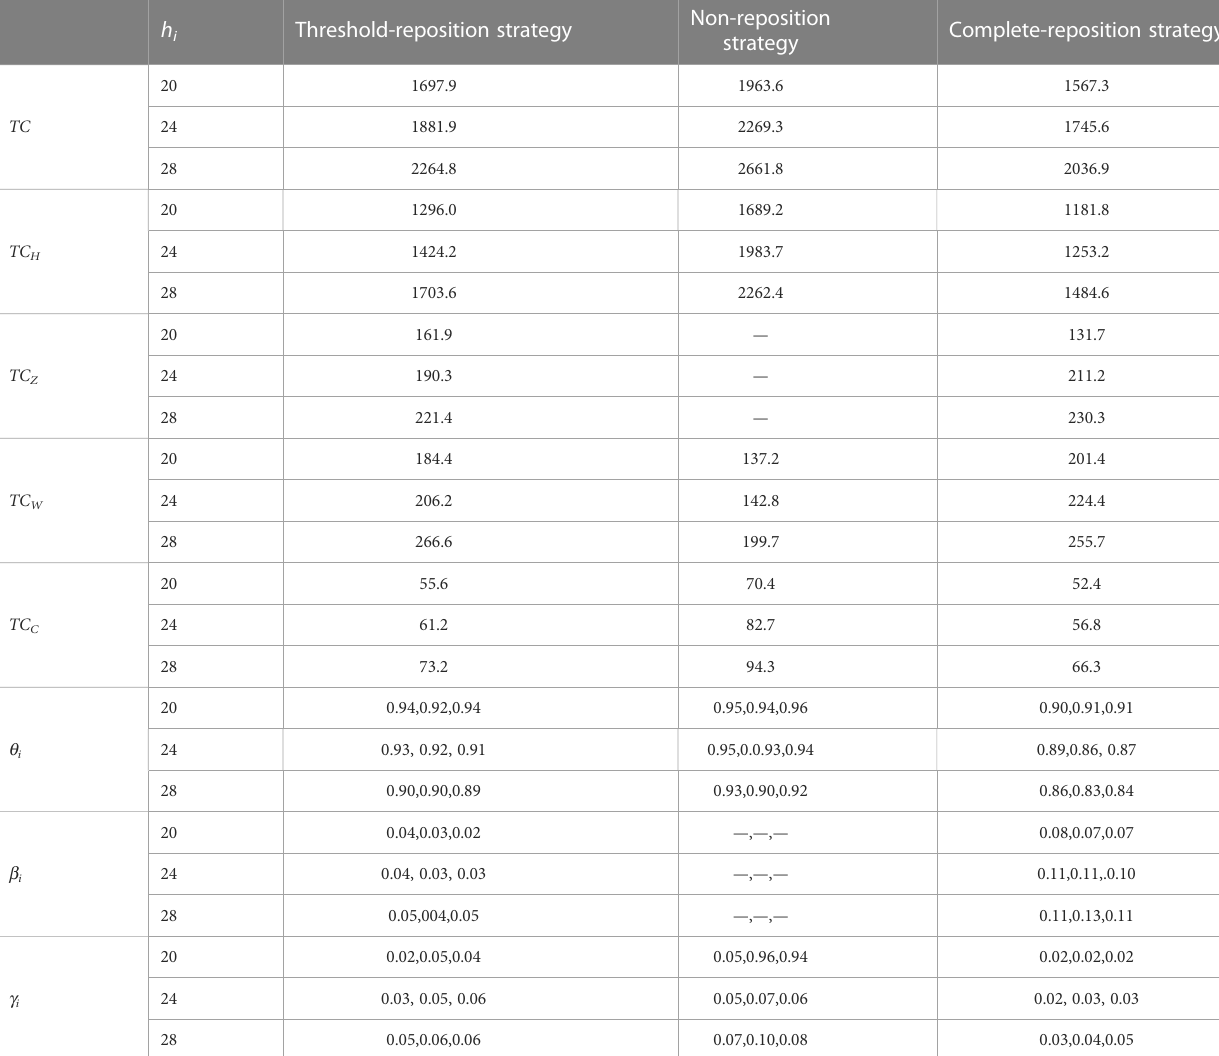
TABLE 4 Analysis of the in fl uence of the change of h i ‘ s on three strategies. h